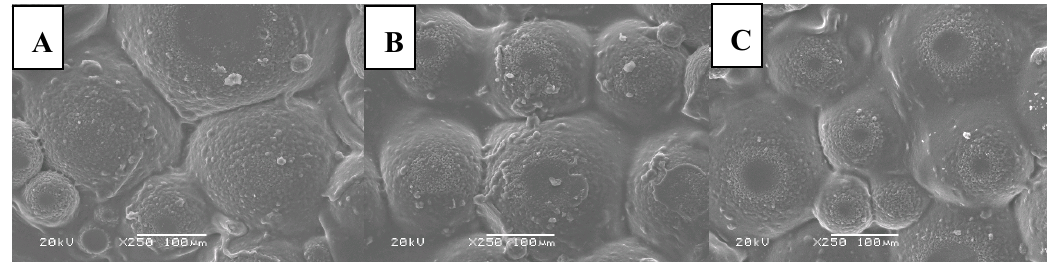
Figure 8. SEM microphotographs of Beetosan ® hydrogels modified with: ( A ) 1 mL; ( B ) 3 mL; ( C ) 5 mL of nanosilver.